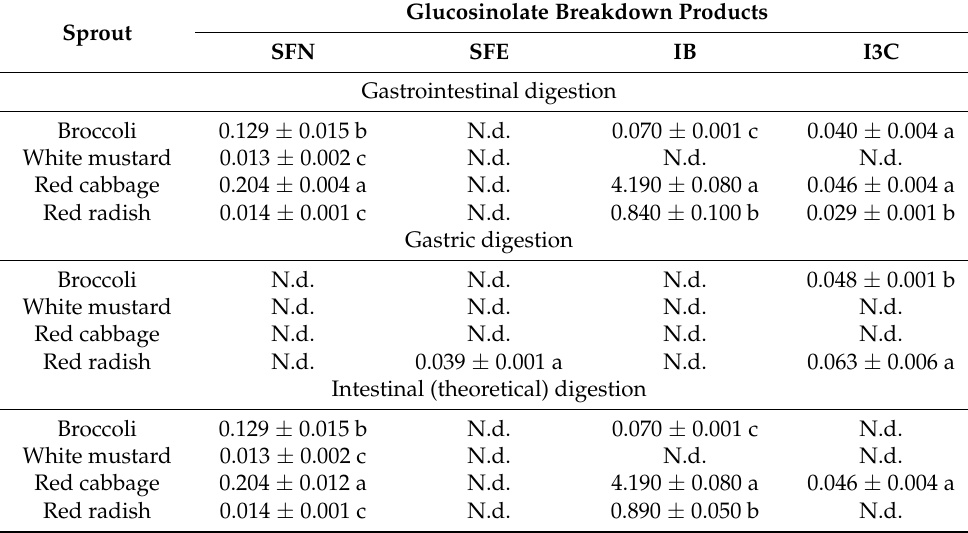
Table 3. Content of bioaccessible individual isothiocyanates and indoles (mg/100 g fw) extracted from different plant materials due to gastric, intestinal, and gastrointestinal digestion.